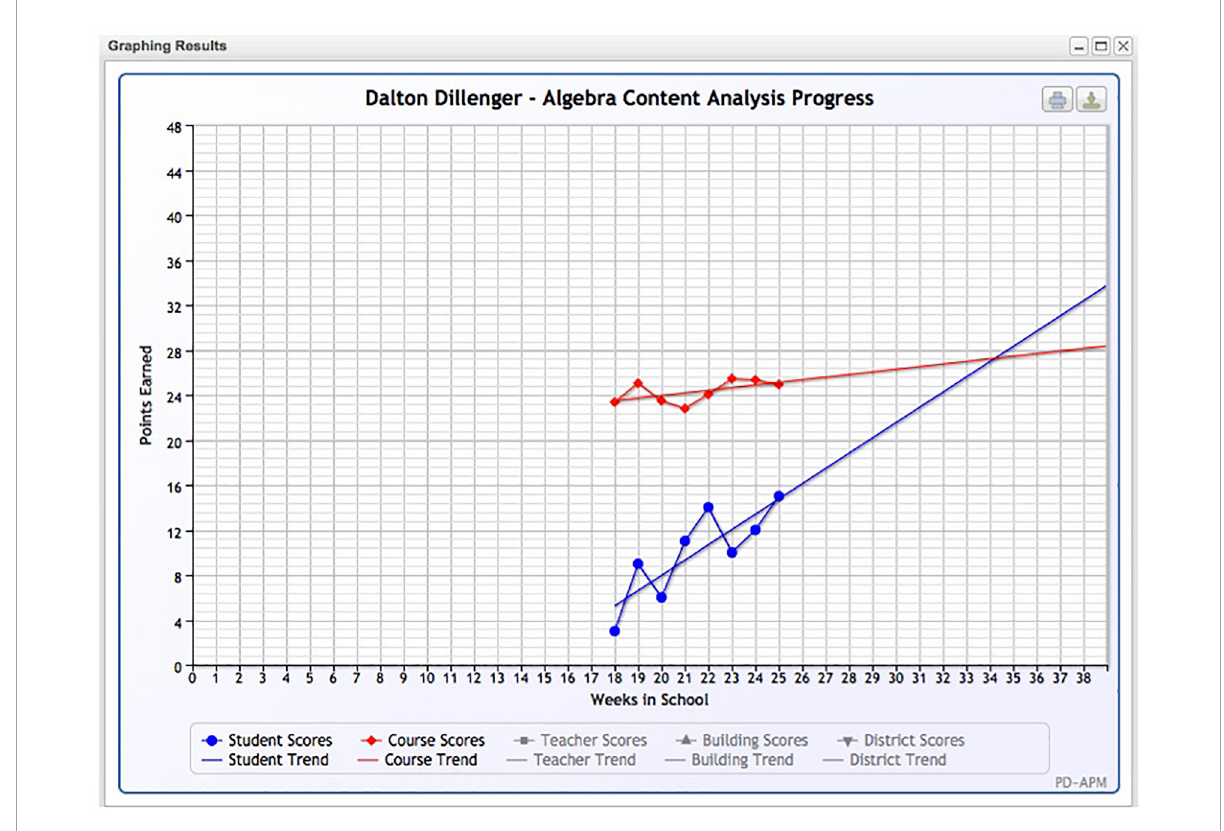
FIGURE1 Progress monitoring graph showing student data and class comparison